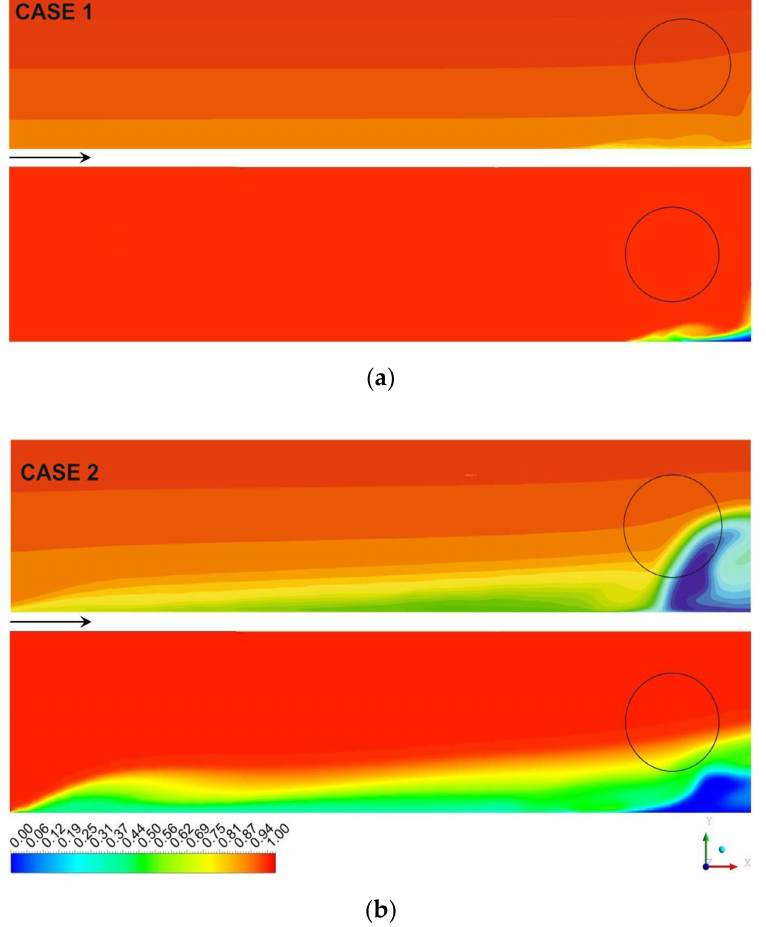
Figure 10. Distribution of the dimensionless temperature T* in the middle plane of the T-junction (black circle—inlet opening of the socket): ( a )—ST1, Table 2 (top figure—LES results [12], bottom figure—RANS results); ( b )—ST2, Table 2 (top figure—LES results [12], bottom figure—RANS results). The overflow occurs at a distance of 0.55 D m from the central axis of the socket (Figure 10) due to a density difference between the main pipe flow and the socket flow. It is 3%. This results in the formation of the recirculating flow zone as shown in Figure 11 illustrating the distribution of the dimensionless velocity U ∗ = U /